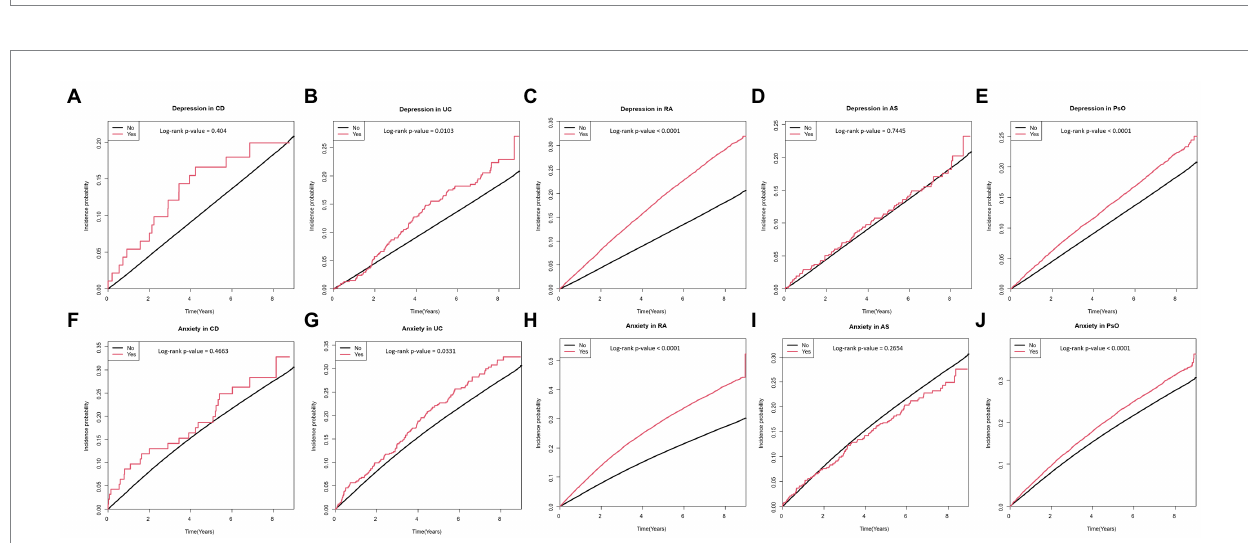
FIGURE 3 Cumulative incidence of depression in patients with (A) CD, (B) UC, (C) RA, (D) AS, and (E) PsO; and cumulative incidence of anxiety in patients with (F) CD, (G) UC, (H) RA, (I) AS, and (J) PsO. CD, crohn’s disease; UC, ulcerative colitis; RA, rheumatoid arthritis; AS, ankylosing spondylitis; PsO,